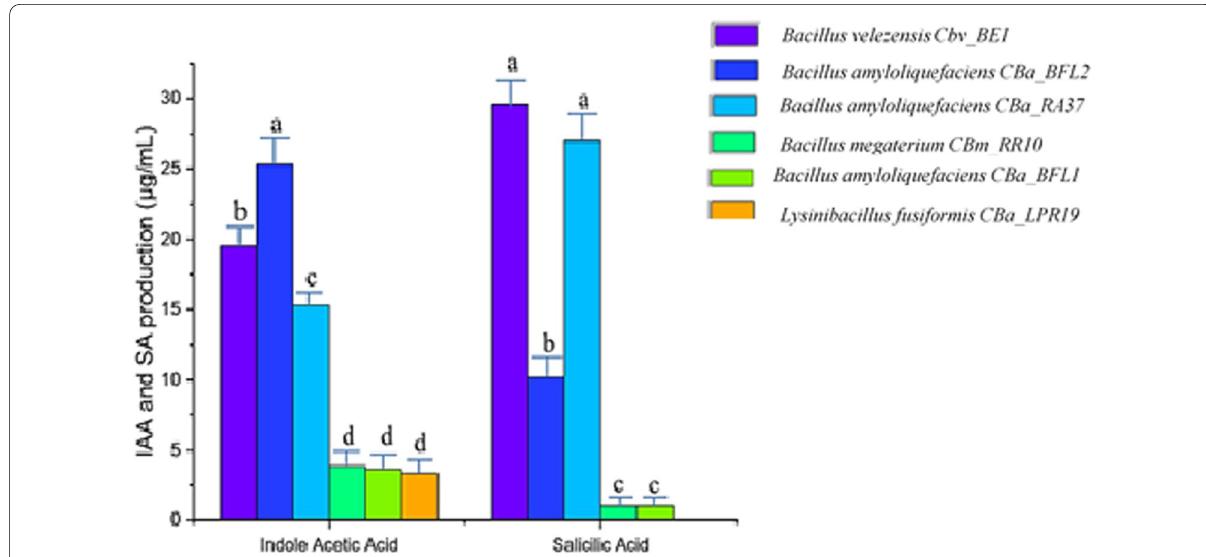
Fig. 3 Quantitative estimation of salicylic acid and indole acetic acid production by the bacterial endophytes. Bar charts (IAA or SA) bearing different alphabet letters denote significantly different effects at p